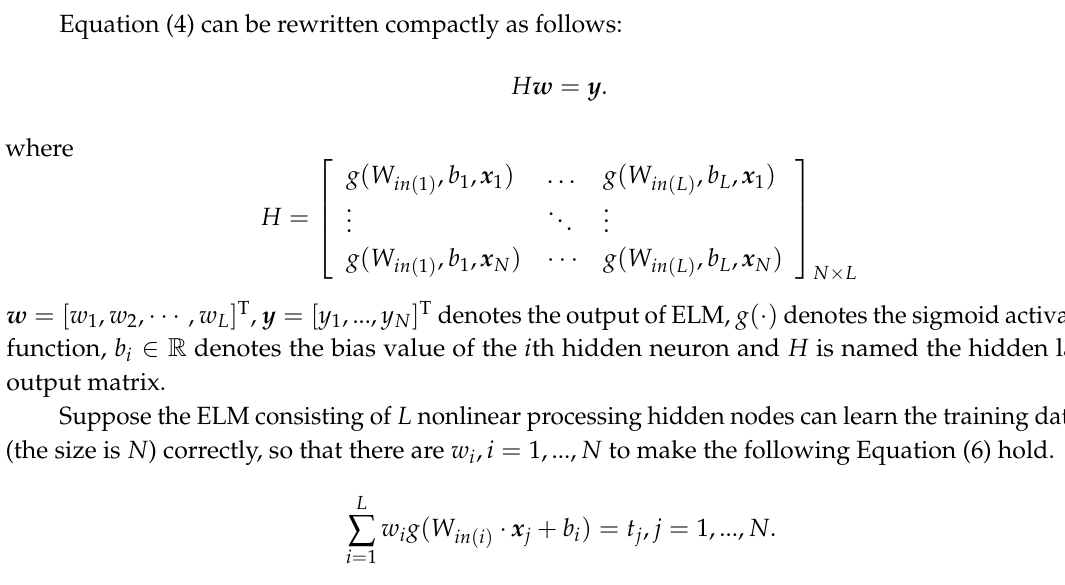
Figure 1. Classification results by different algorithms on AVIRIS image